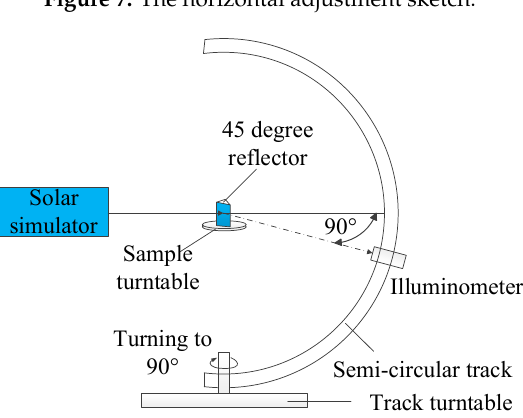
Figure 7. The horizontal adjustment sketch.